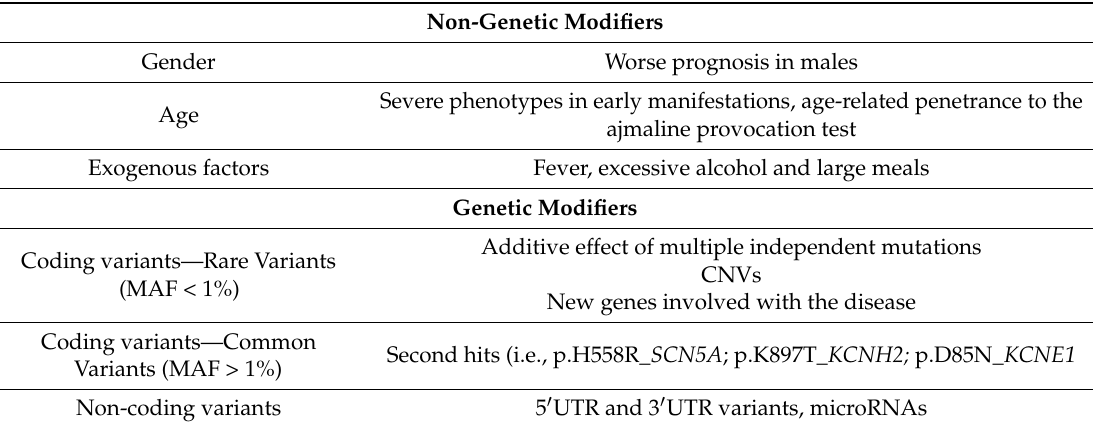
Table 1. Genetic and non-genetic factors associated with incomplete penetrance and variable